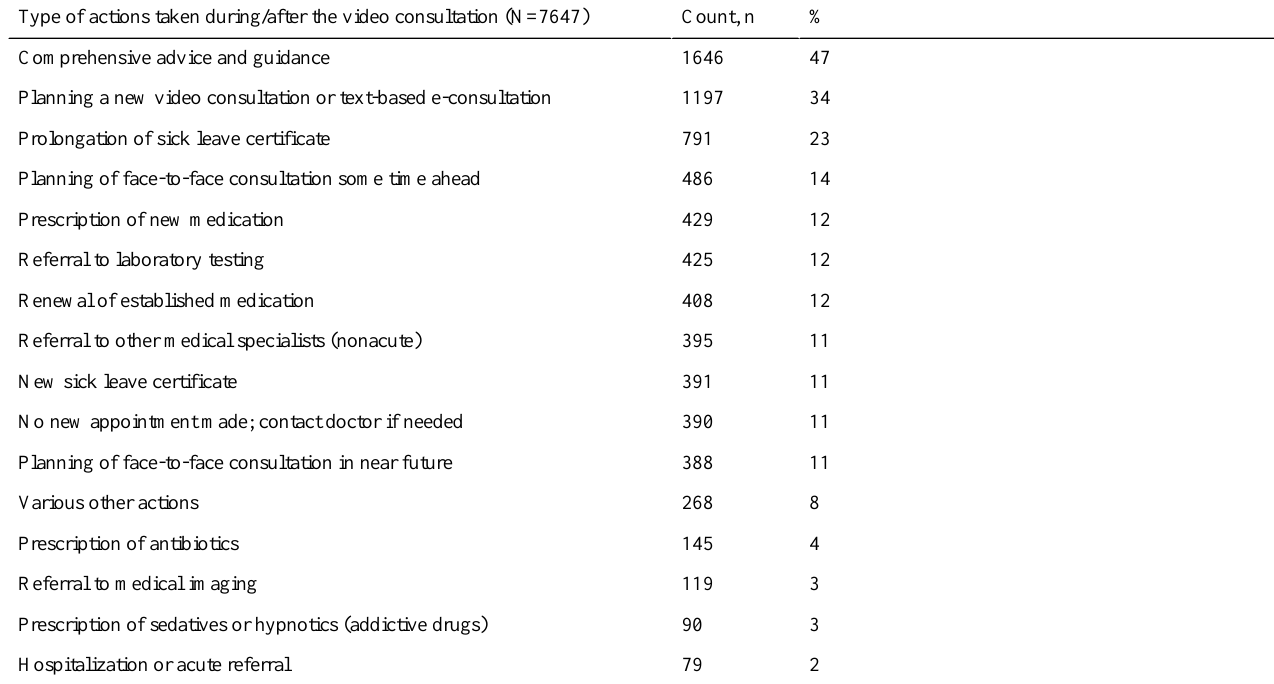
Table 5. Action taken during/after the 3484 evaluated video consultations. Several actions could be registered for each video consultation. a